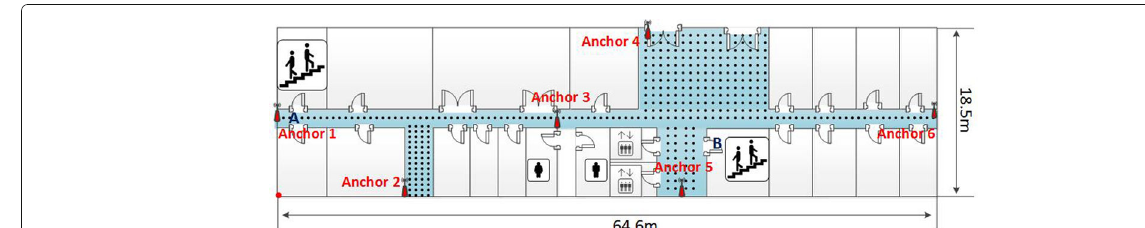
Fig. 17 Floor plan of the lower floor